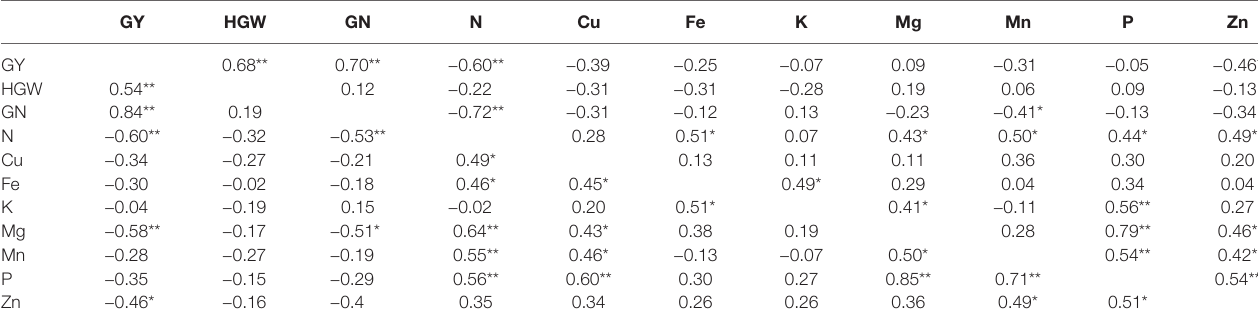
TABLE 4 | Correlation coef fi cients (r) between grain yield (GY), hundred grains weight (HGW), grain number per panicle (GN), and mineral nutrients (N, Cu, Fe, K, Mg, Mn, P, and Zn) concentration in maize at Shun-Yi (SY) across 2 years (2010 and 2011). GY HGW GN